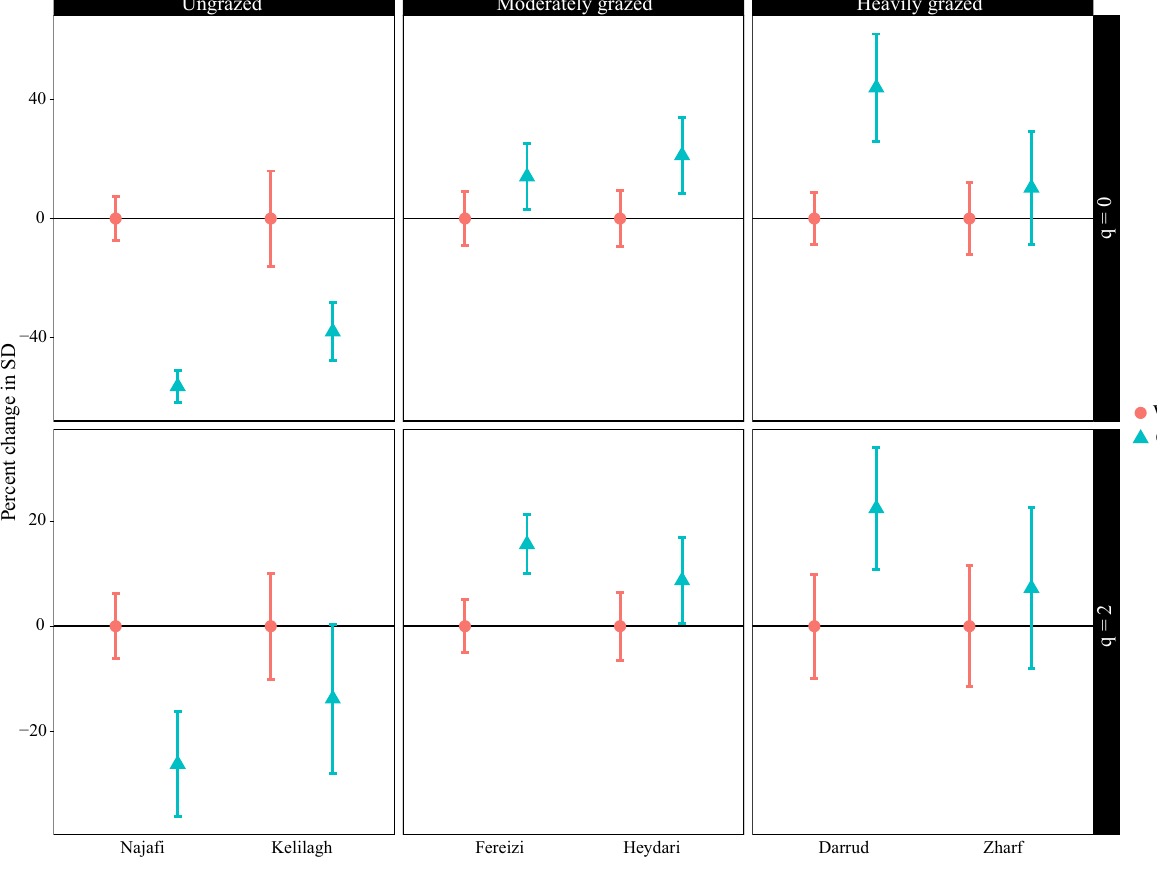
Figure 2. The coverage-based comparison of Hill phylogenetic diversity of the plant communities containing (CFSs) and without (WFSs) Phlomis cancellata in different grazing conditions. The phylogenetic richness (q = 0) and phylogenetic diversity of dominant species (q = 2) were reported in this study. PD = phylogenetic diversity. The results are reported as the percentage change in PD of CFSs comparing to that of